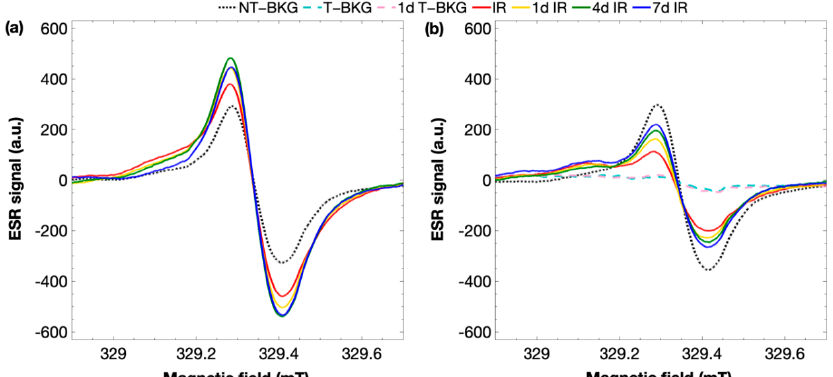
Figure 3. Evolution of the ESR spectra recorded at di ff erent times in ( a ) non-chemically and ( b ) chemically treated fingernail samples exposed to 20 Gy of 137 Cs γ -rays following storage in the vacuum chamber (2% air humidity level, 20 ◦ C temperature). The notations NT − BKG and T − BKG correspond to the background signal before irradiation for non-chemically treated samples and after chemical treatment for those chemically treated, respectively. IR represents γ -ray